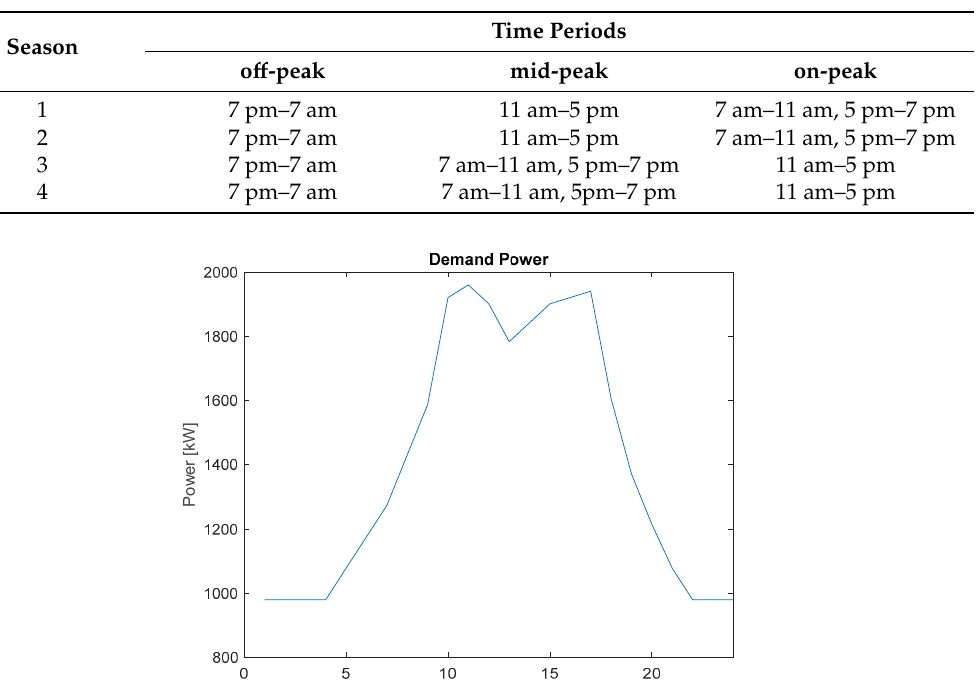
Table 5. Time-of-use periods for each season [44].